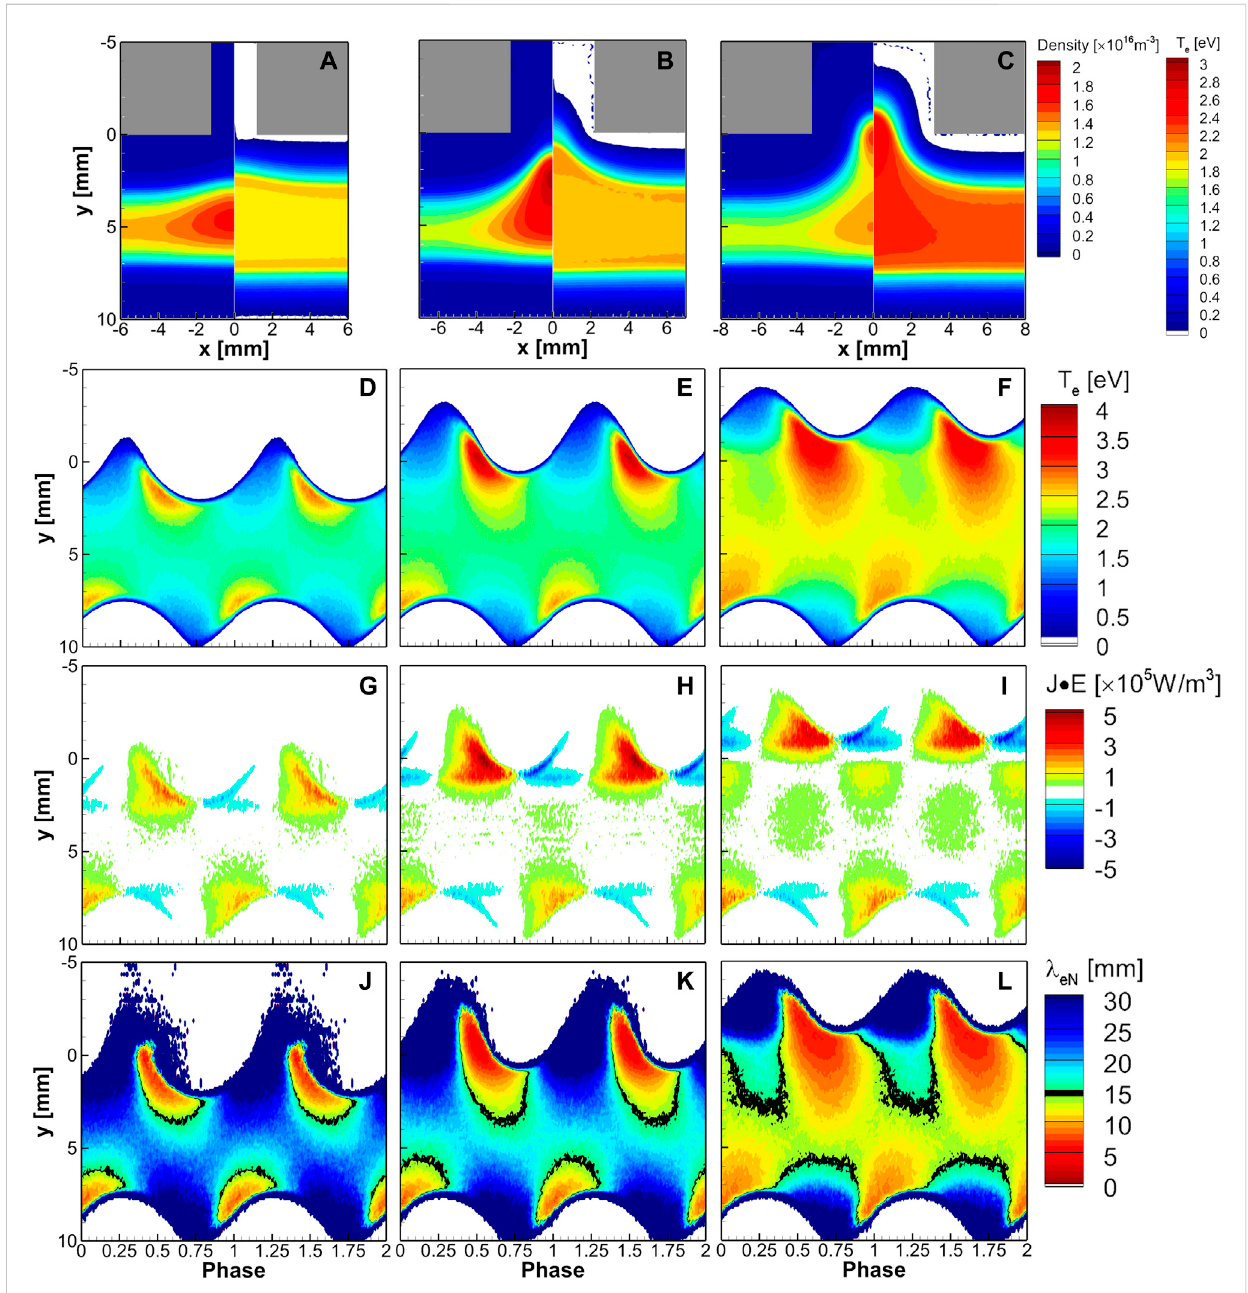
FIGURE 7 Shownare time-averagedspatial pro fi lesofelectrondensity (leftside) and temperature (right side)for thehole widthof (A) 2 mm, (B) 4 mm, and (C) 6 mm. The phase-resolved spatiotemporal pro fi les at x = 0 position are provided for each case for (D) – (F) electron temperature, (G) – (I) electron power absorption, and (J) – (L) ensemble-averaged electron energy relaxation length, λ eN . The black line means the position where λ eN = 15